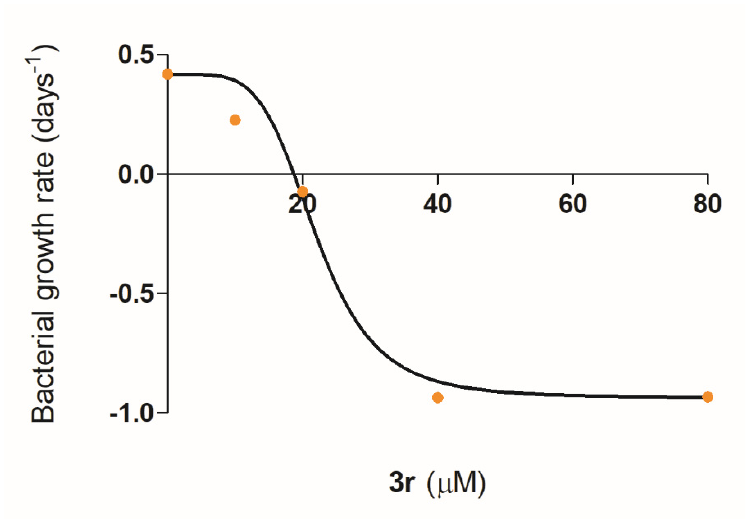
Figure 3. Pharmacodynamic model fitted to estimated growth rates. The points indicate the estimated bacterial growth rates at different concentrations of compound 3r . The solid line shows the model with the calculated growth rates.